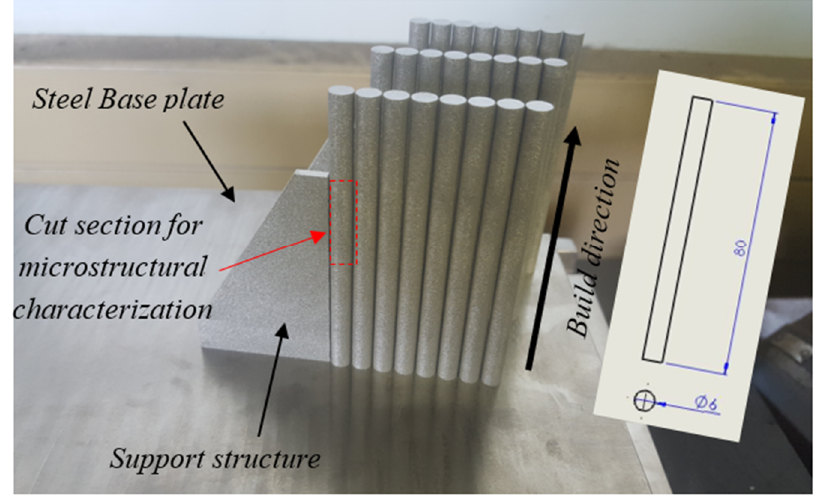
Figure 1. A photograph showing the DMLS-manufactured Ti6Al4V(ELI) test specimens on a steel base plate. The insert schematic drawing shows the dimensions of the specimens in millimeters.